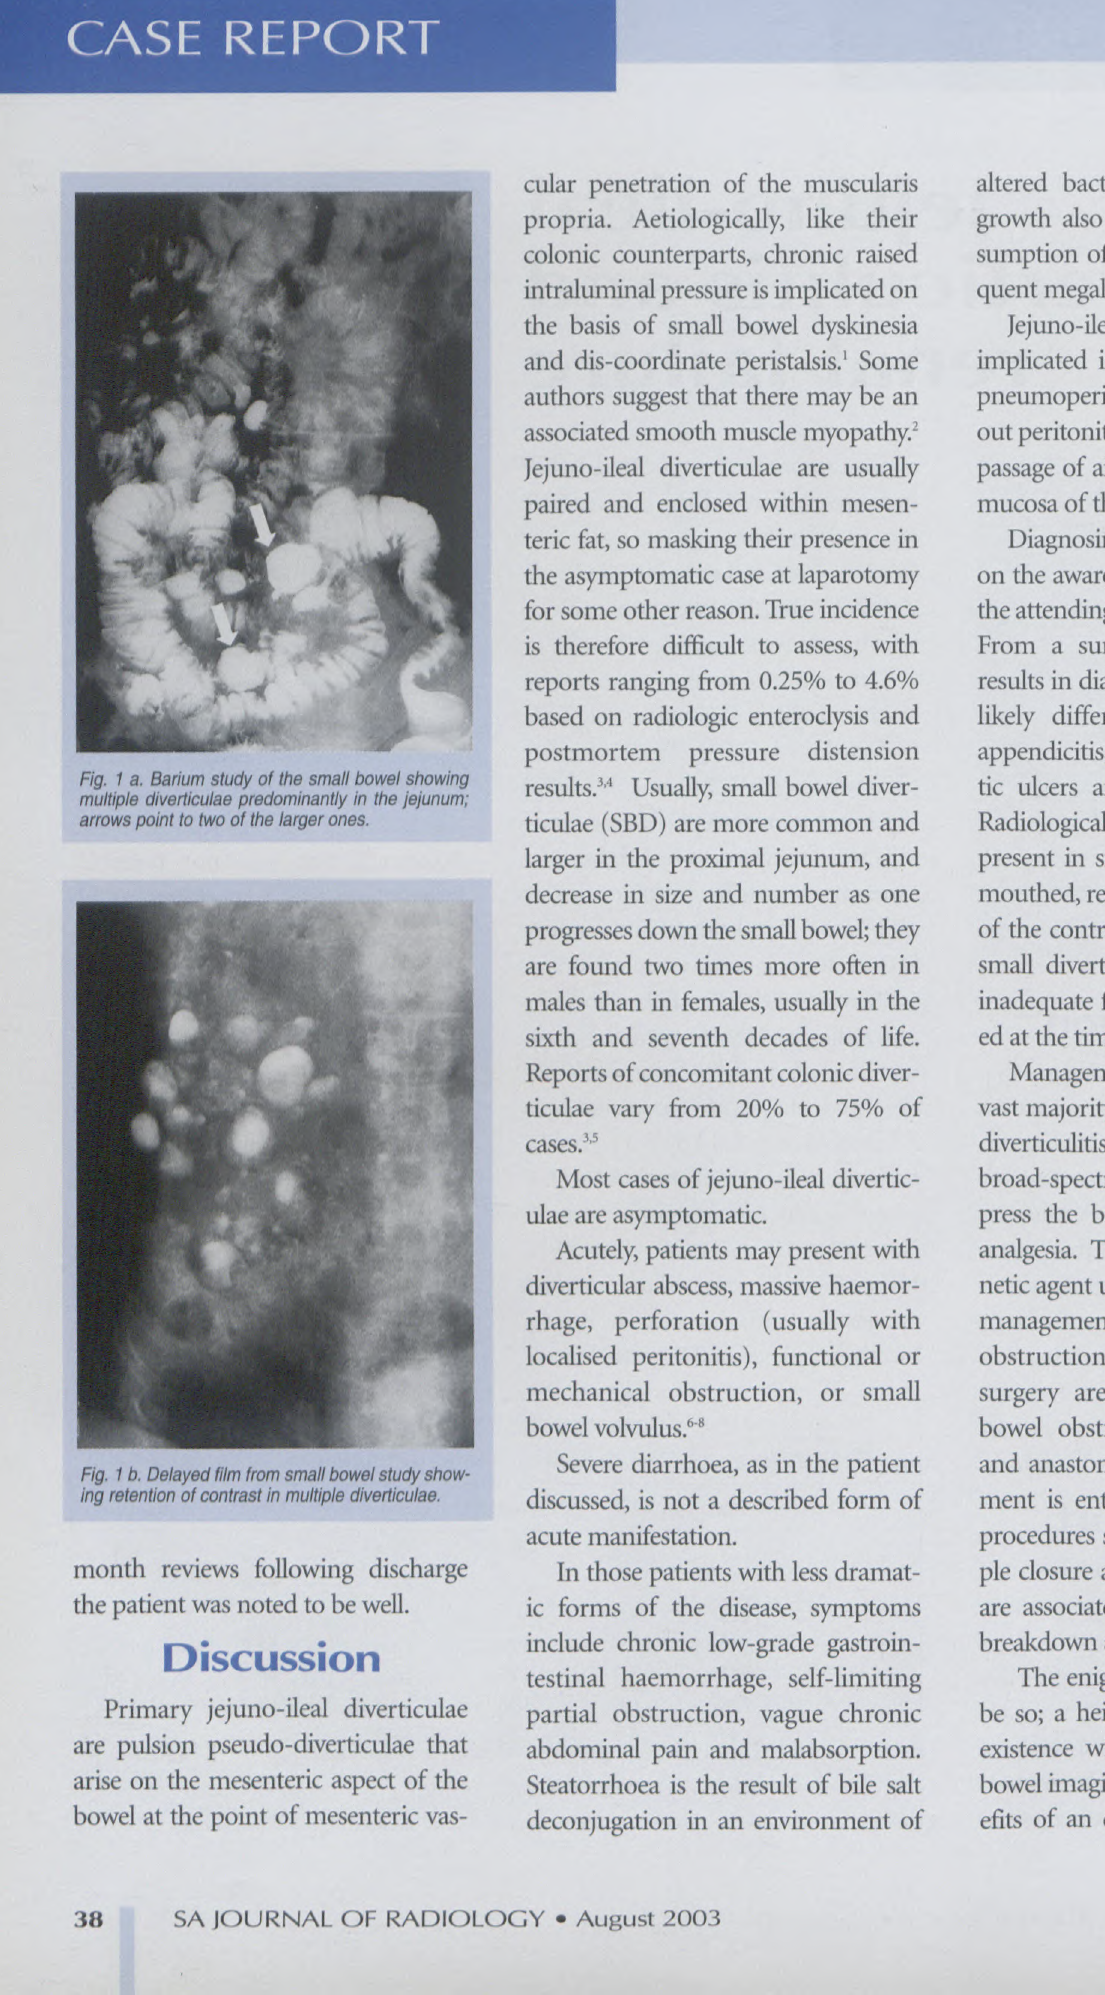
Fig. 1 a. Barium study of the small bowel showing multiple diverticulae predominantly in the jejunum; arrows point to two of the larger ones.